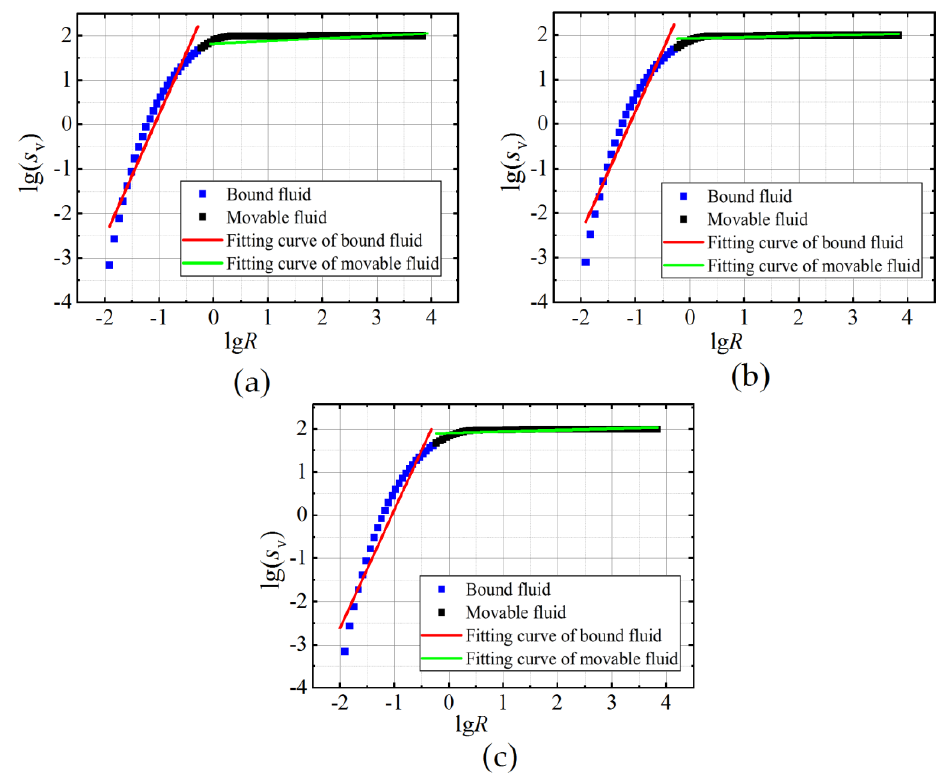
Figure 10. The lg S v-lg R curves under various freezing temperatures: ( a – c ) represent − 3 ◦ C, − 8 ◦ C and − 20 ◦ C,